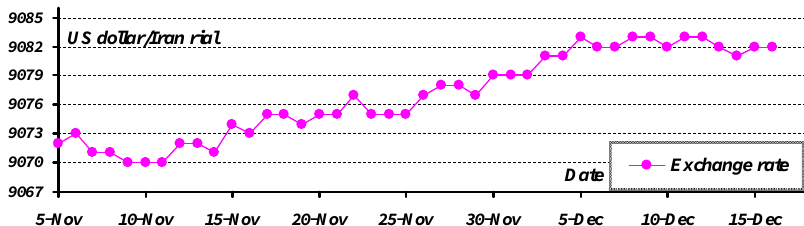
Fig. 3 Exchange Rate (US dollar/ Iran rial) from 5 Nov to 16 Dec 2006 .